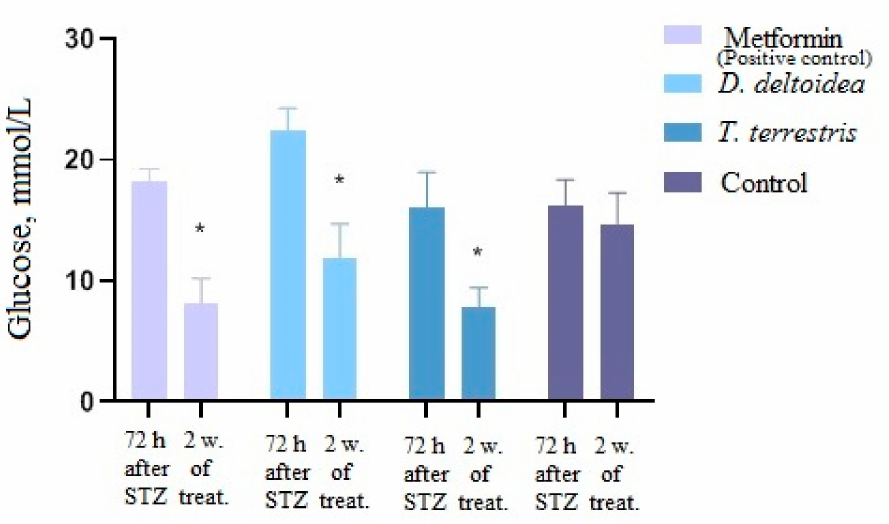
Figure 7. Change of glucose level in blood after treatment with metformin and phytopreparations. * Significantly different from the period after administration of STZ. Control—STZ treatment followed by administration of sodium chloride, w—weeks and